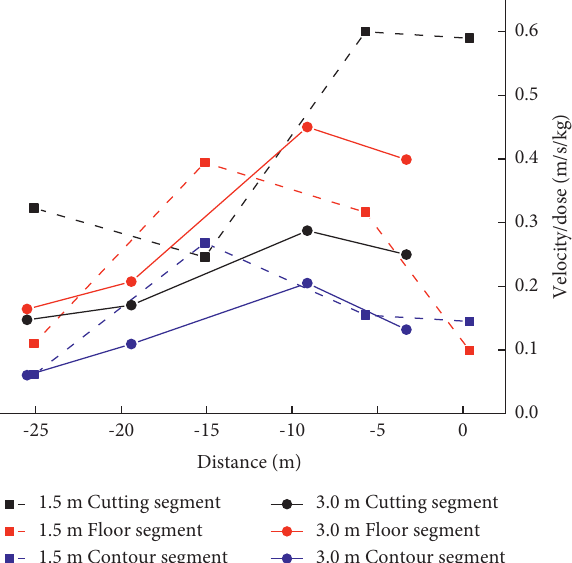
Figure 8: Comparison of the ratios of the vibration velocity to single-segment explosive charge of the typical blasting segments with different footage conditions behind the corresponding blasting